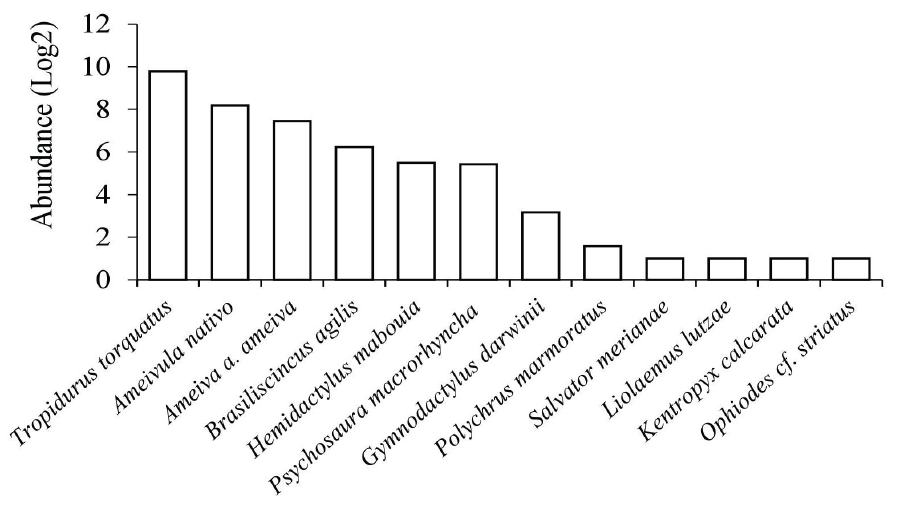
) of lizards recorded at: Itaúnas State Park; Conceição da Barra Figure 2 - Total abundance (log 2 Environmental Protection Area; Comboios Biological Reserve; Paulo Cesar Vinha State Park and Praia das Neves. Species are ranked from highest to lowest abundance.